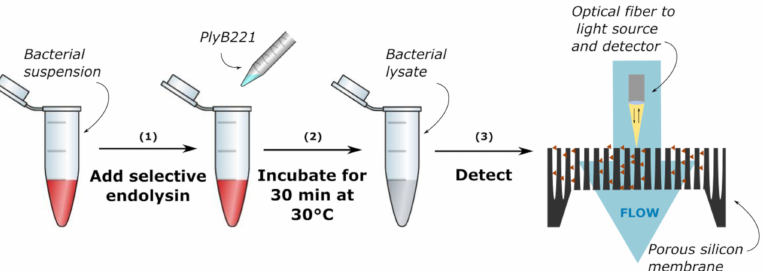
Figure 2. Protocol of bacteria detection through their lysate: ( 1 ) lysis of the bacteria using a selective endolysin, ( 2 ) incubation for 30 min and ( 3 ) optical detection on a porous silicon